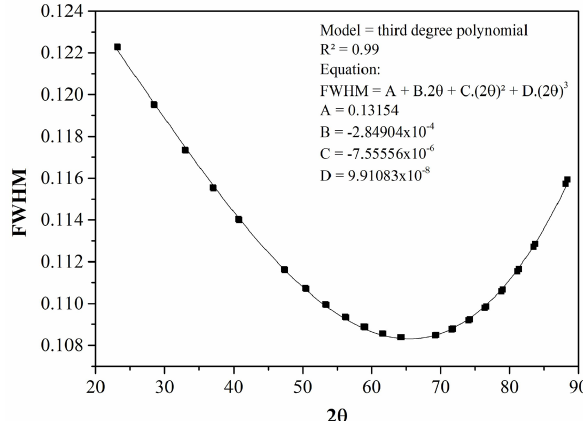
Figure 2. Instrumental broadening result of silicon, refinement was performed by the Rietveld method with the aid of Fullprof